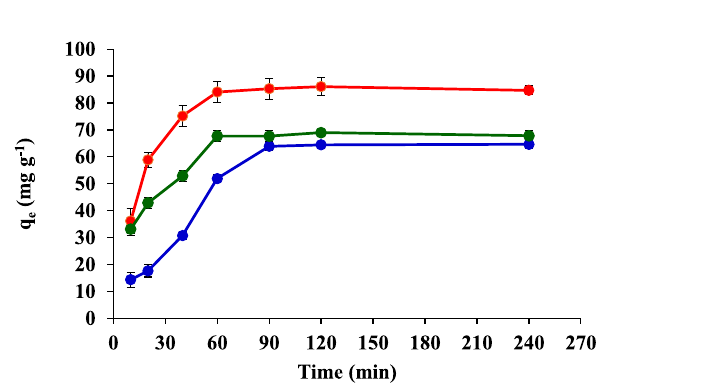
Figure 10. Effect of the contact time on the adsorption of CR, CB, and